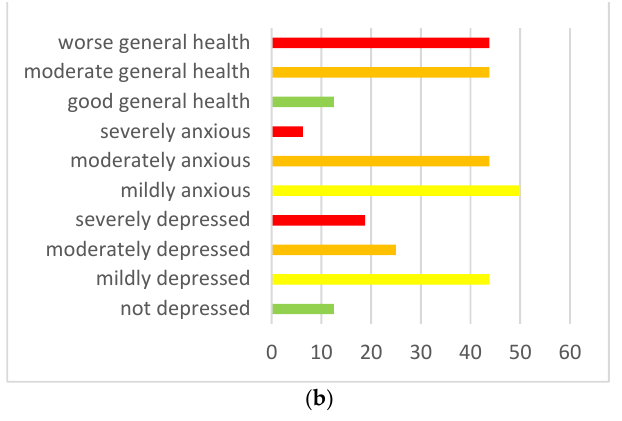
Figure 2. ( a ) Parents symptomatology in the clinic group. ( b ) Parental symptomatology in the control group. Legend: red = clinic score; orange = moderate clinic score; yellow: mildly clinic score; green = normal score.